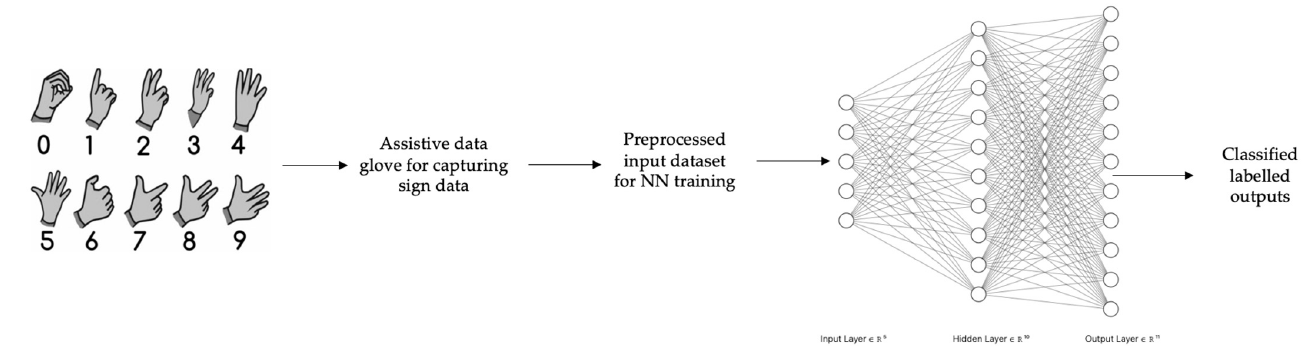
Figure 1. An overview of complete methodology for NN-based ASL